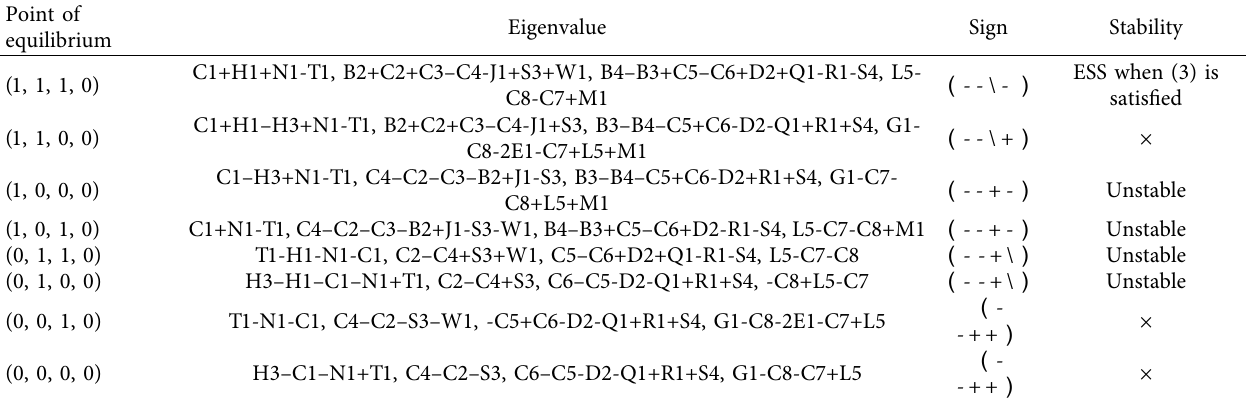
Table 3: Analysis of the gradual stability of the equilibrium point of the replication dynamic system without hard work of the enterprises. Point of